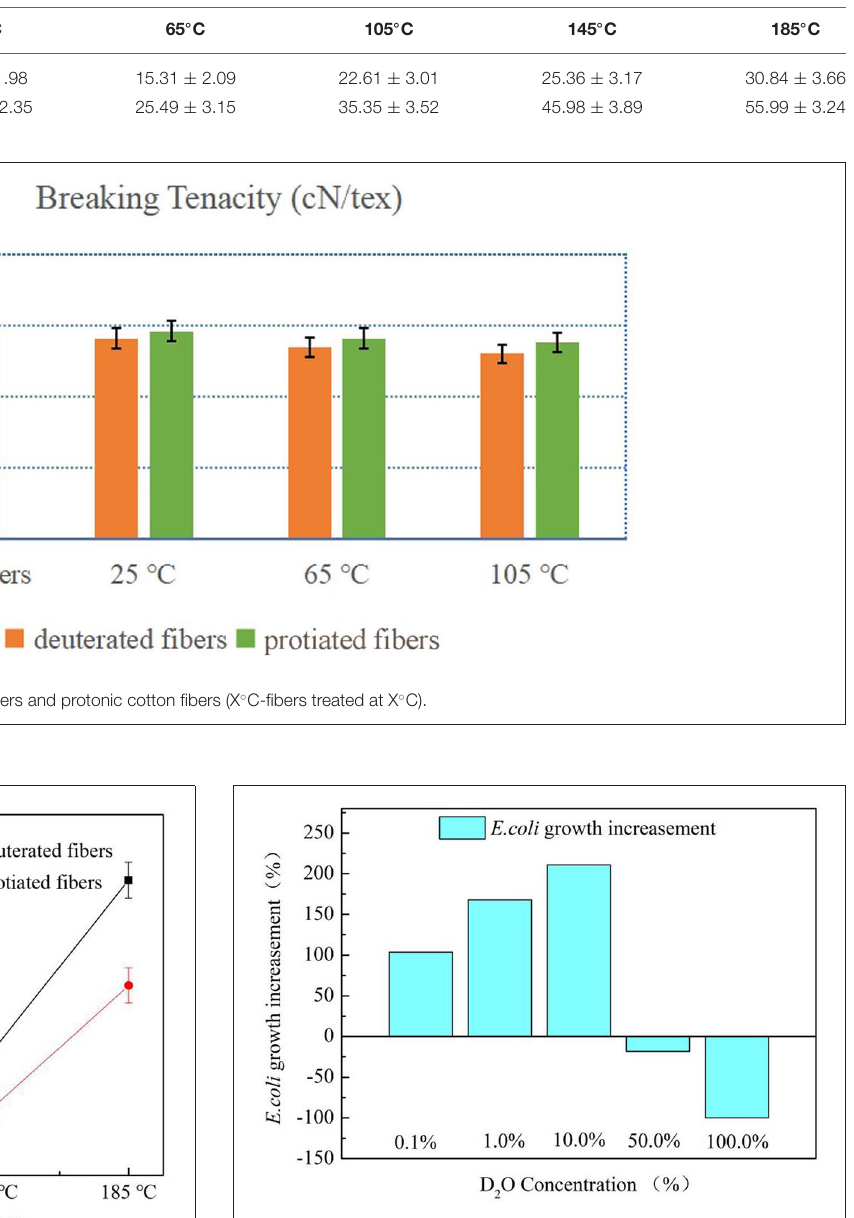
TABLE 1 | Deuteration rate of the deuterated fibers (X ◦ C-fibers treated at X ◦ C).